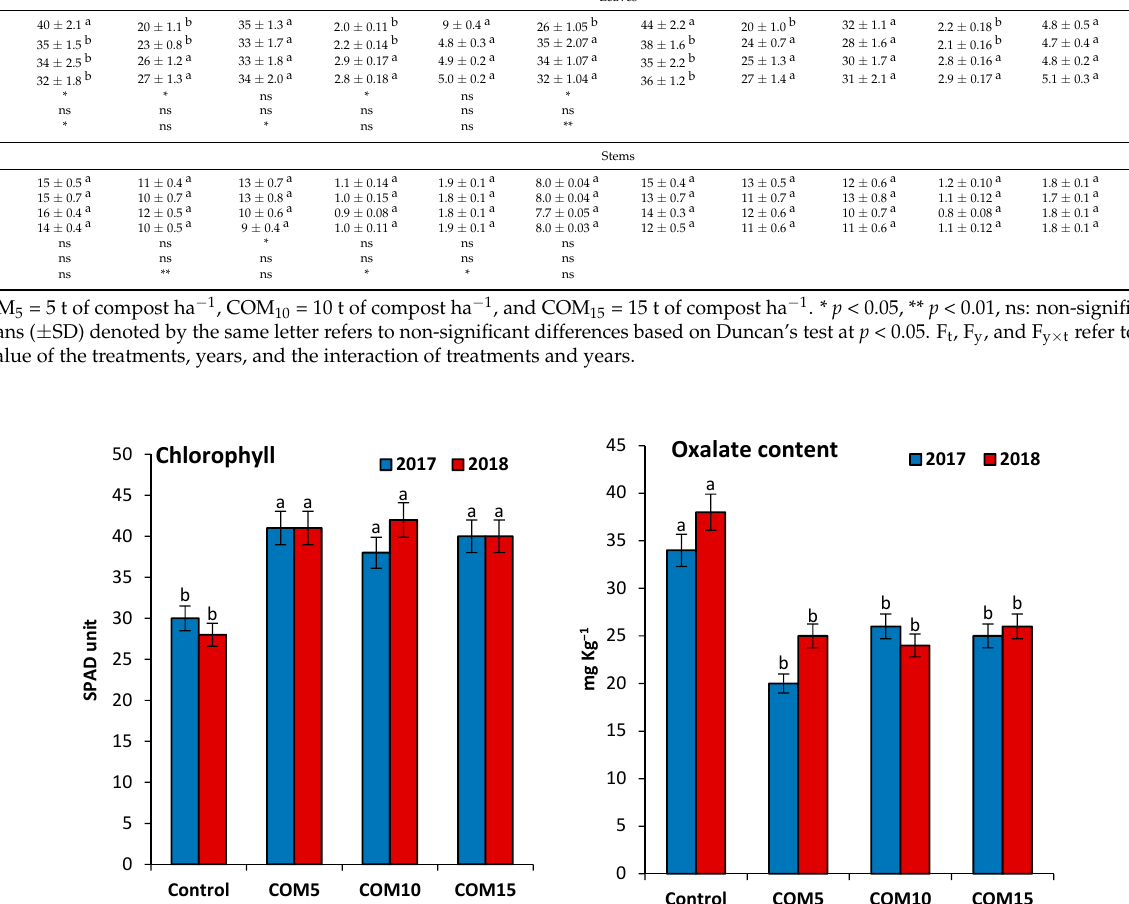
Figure 1. Effect of compost on chlorophyll and oxalate content in the leaves of river saltbush plants. COM 5 = 5 t of compost ha − 1 , COM 10 = 10 t of compost ha − 1 , and COM 15 = 15 t of compost ha − 1 . Means ( ± SD) symbolized by different letters refer to significant differences based on Duncan’s test at p < 0.05. Table 4. Effect of compost on antioxidant enzyme activities (unit mg − 1 protein) in the leaves of river saltbush plants.